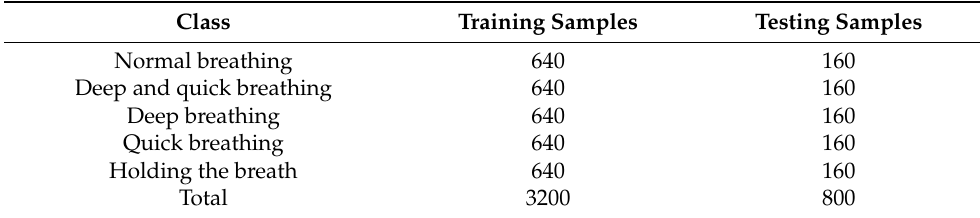
Table 2. Data set for training and